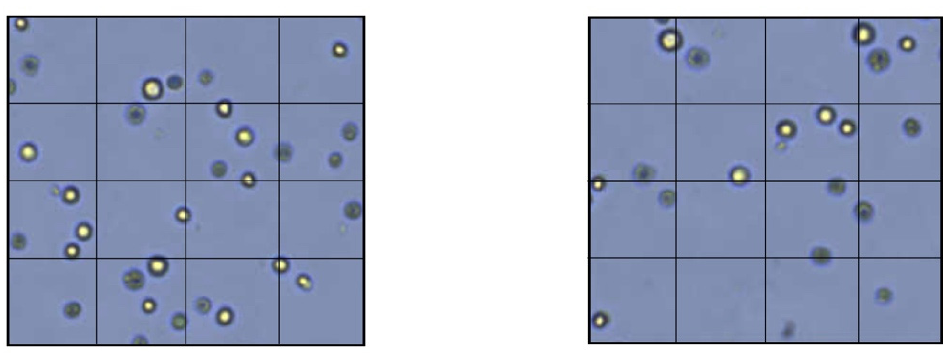
Figure 3. Membrane permeability test with TEM. Left: HPMSCs directly cultured onto a PDADM. Right: HPMSCs directly cultured onto a PHADM.